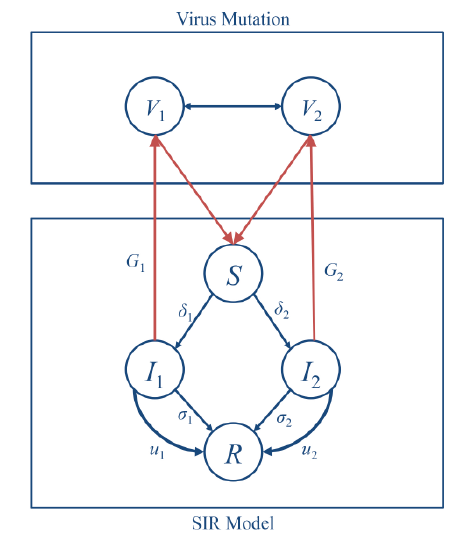
Figure 1. Transition rule: Scheme describes the reaction to two heterogeneous viruses circulating in a population. We assumed that the epidemic process could be controlled using treatment or quarantine methods. These measures can be considered as the control parameters in the system, which are used to reduce the size of the infected population and terminate the epidemic